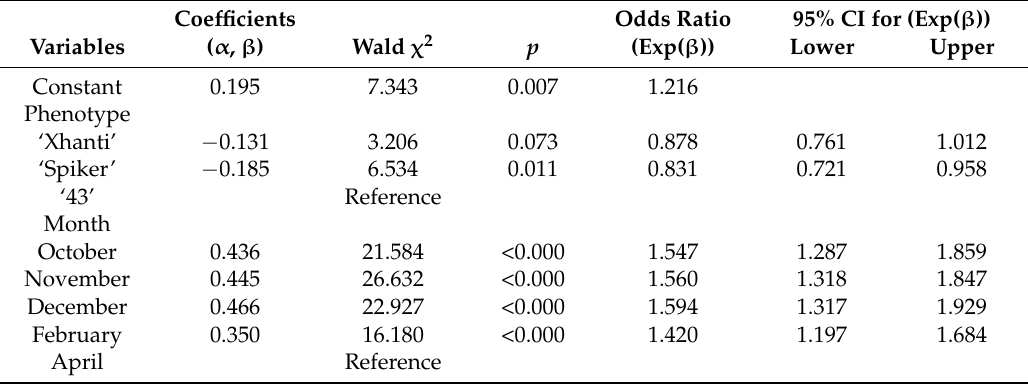
Table 6. Estimation of multiple logistic regression parameters in Tribelli XL ® pepper (‘43’, ‘Spiker’, and